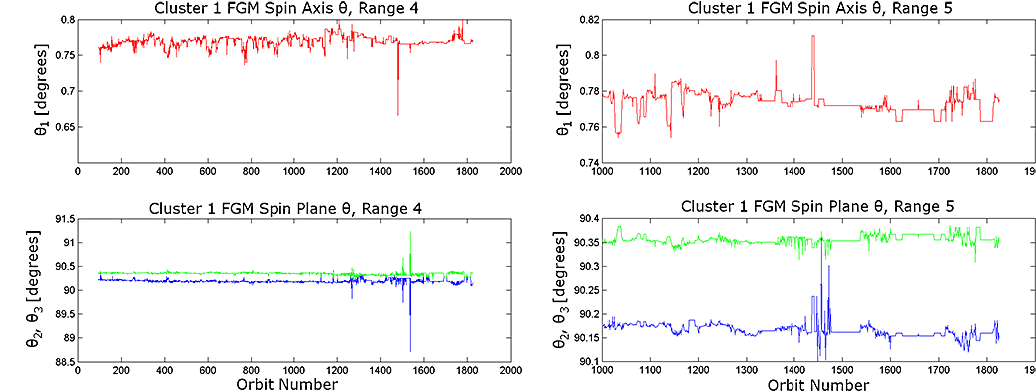
Figure 13. Elevation angle, θ i , plots for C1, ranges 4 and 5, from February 2001 to February 2012.